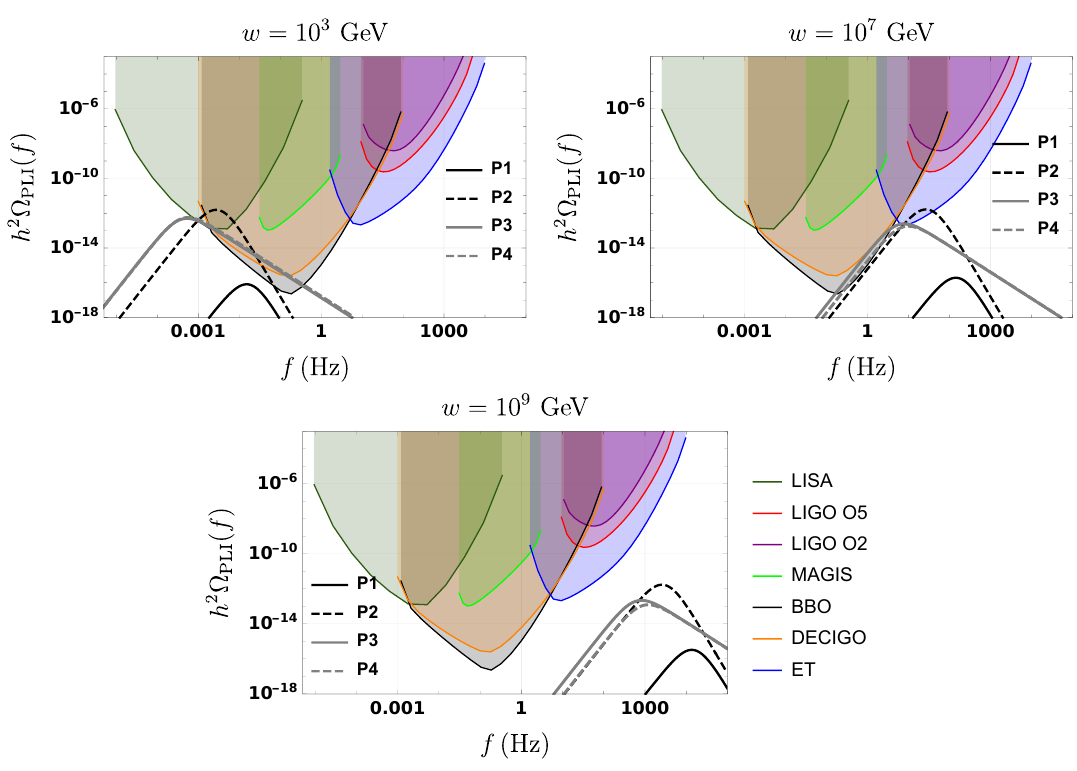
Figure 8 . Same as (cid:12)gure 5 for the values of the scale w = 10 3 ; 10 7 ; 10 9 GeV.